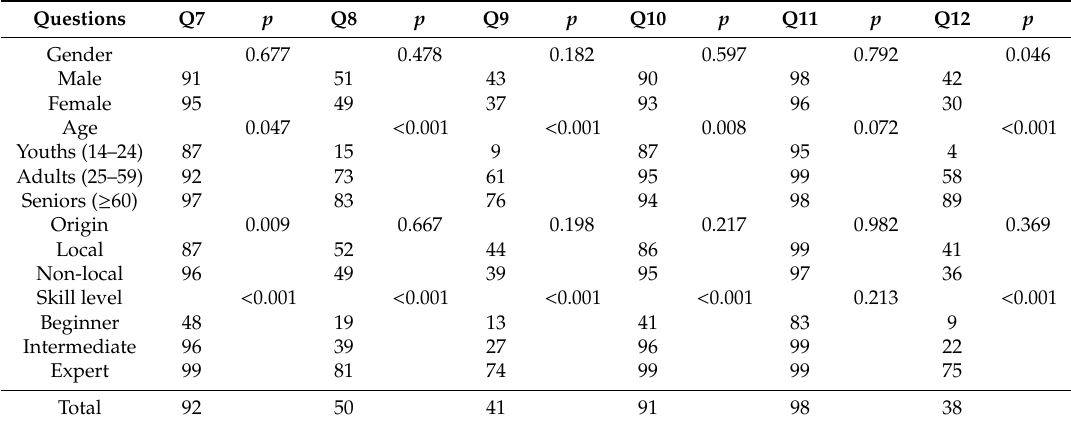
Table 9. Passive knowledge of existing rules